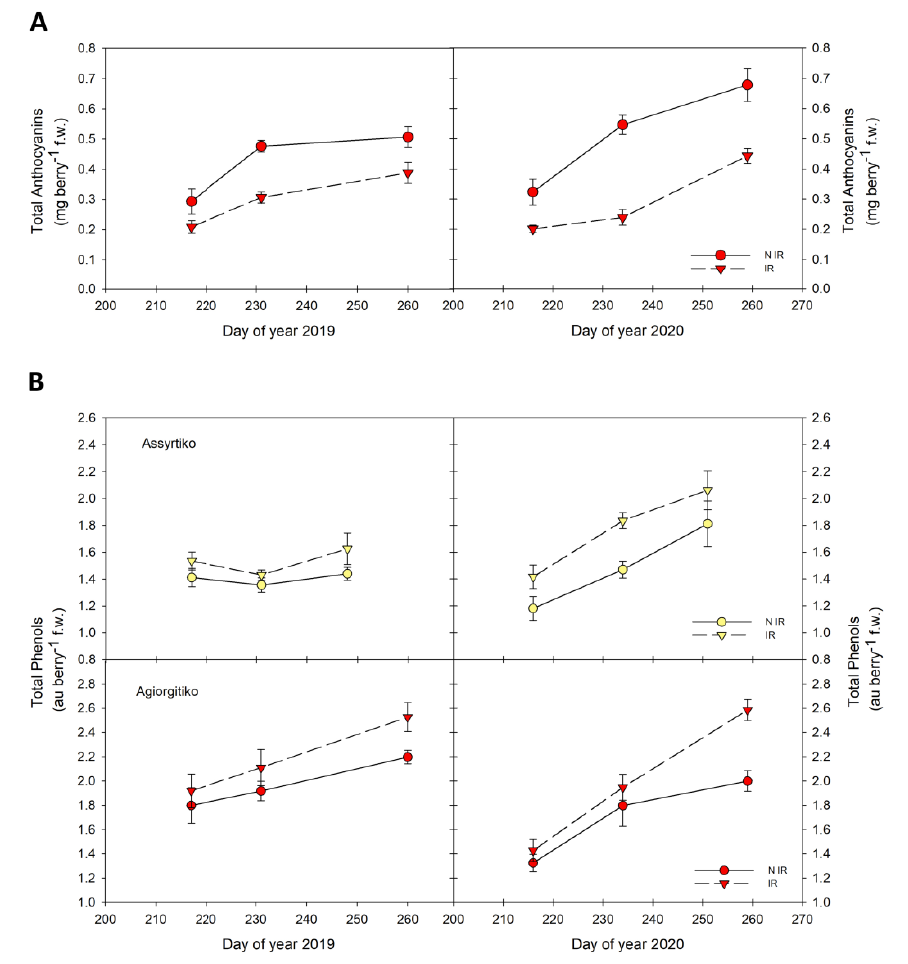
Figure 3. The effect of water deficit on anthocyanins and total phenols during ripening. ( A ). berry total anthocyanins of Agiorgitiko. ( B ). berry total phenols of the two cultivars. Vertical bars indicate the standard deviation of mean values. IR, irrigated; NIR, non-irrigated.